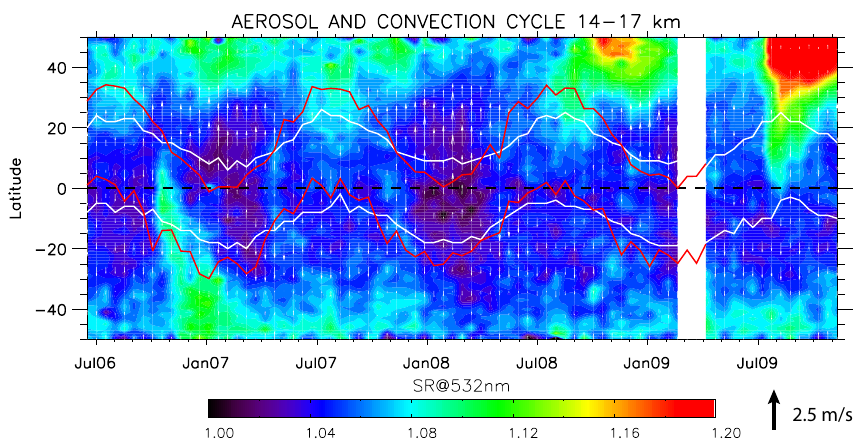
Fig. 5. Evolution of the mean SR between 14–17km from CALIPSO. Superimposed are, in red, the mean ITCZ latitudinal location as revealed by the 10th and 90th percentile frequency of MCS and in white, that of cirrus clouds, given respectively by the TRMM PR and CALIPSO. The cloudy pixel from CALIPSO are determined using the depolarization ratio channel. The white arrows represent the mean meridionnal component of ECMWF wind field every 16